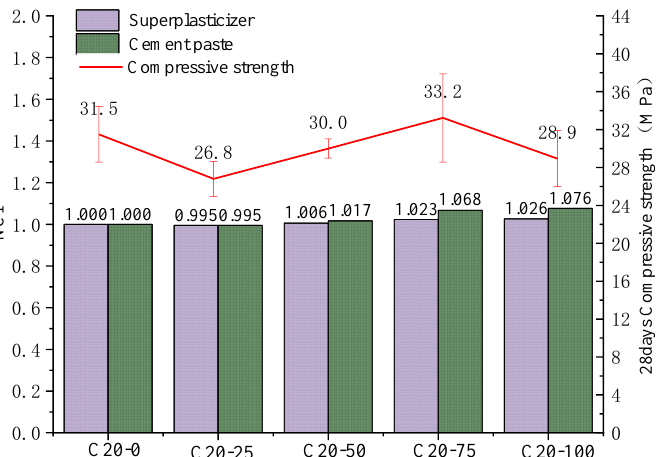
Figure 20. Cost index and compressive strength of C20 concrete at the curing age of 28 days.